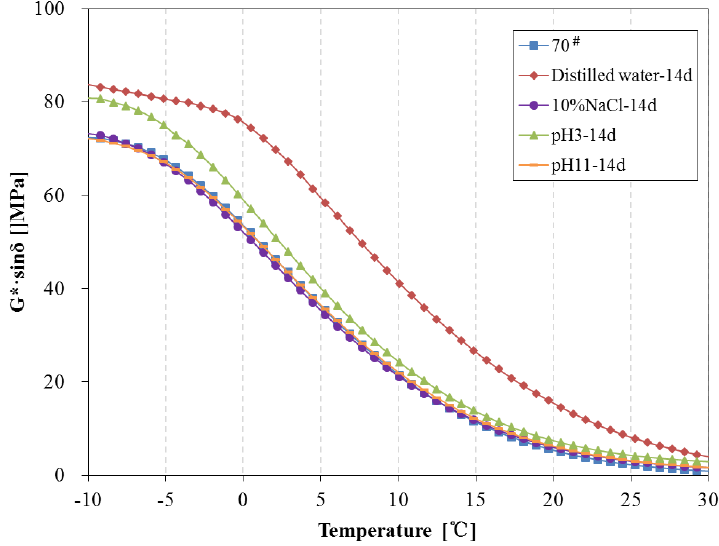
Figure 13. Fatigue factor of 70 # asphalt before and after 14 days immersion.